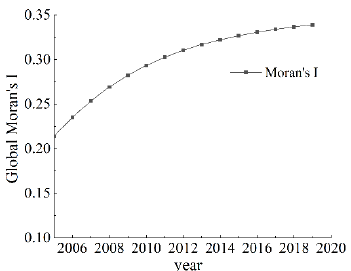
Figure 5. The Moran’s I value of urban ecological welfare performance in 2005–2019.